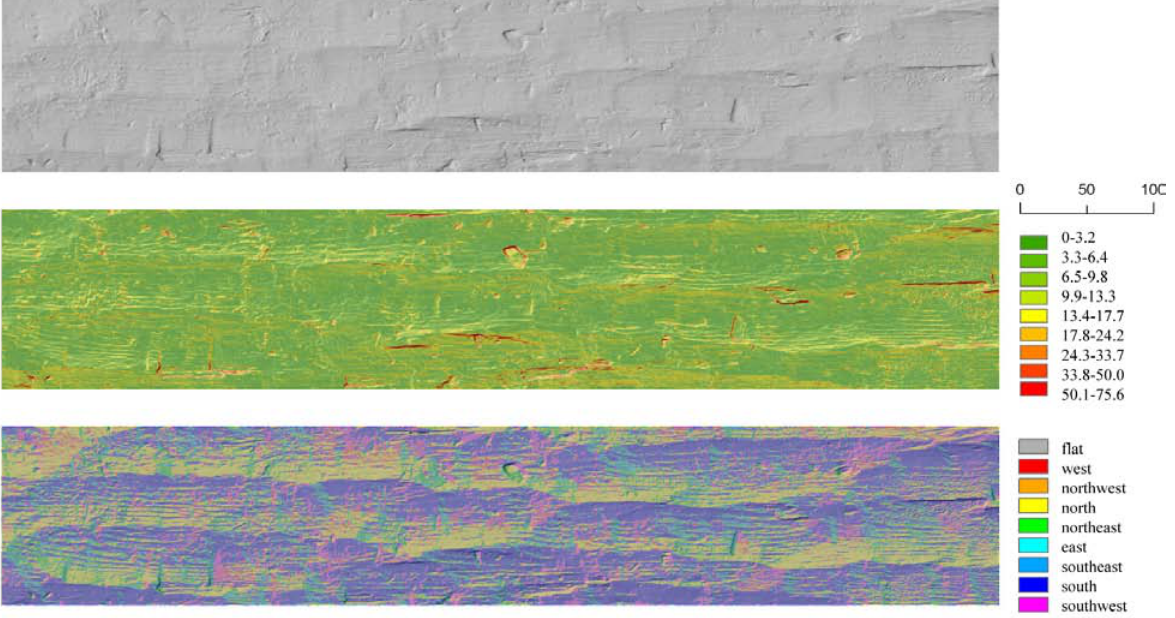
Figure 8. Surface analysis of the archaeological find in mm (up: hillshade model, middle: slope analysis, down: aspect